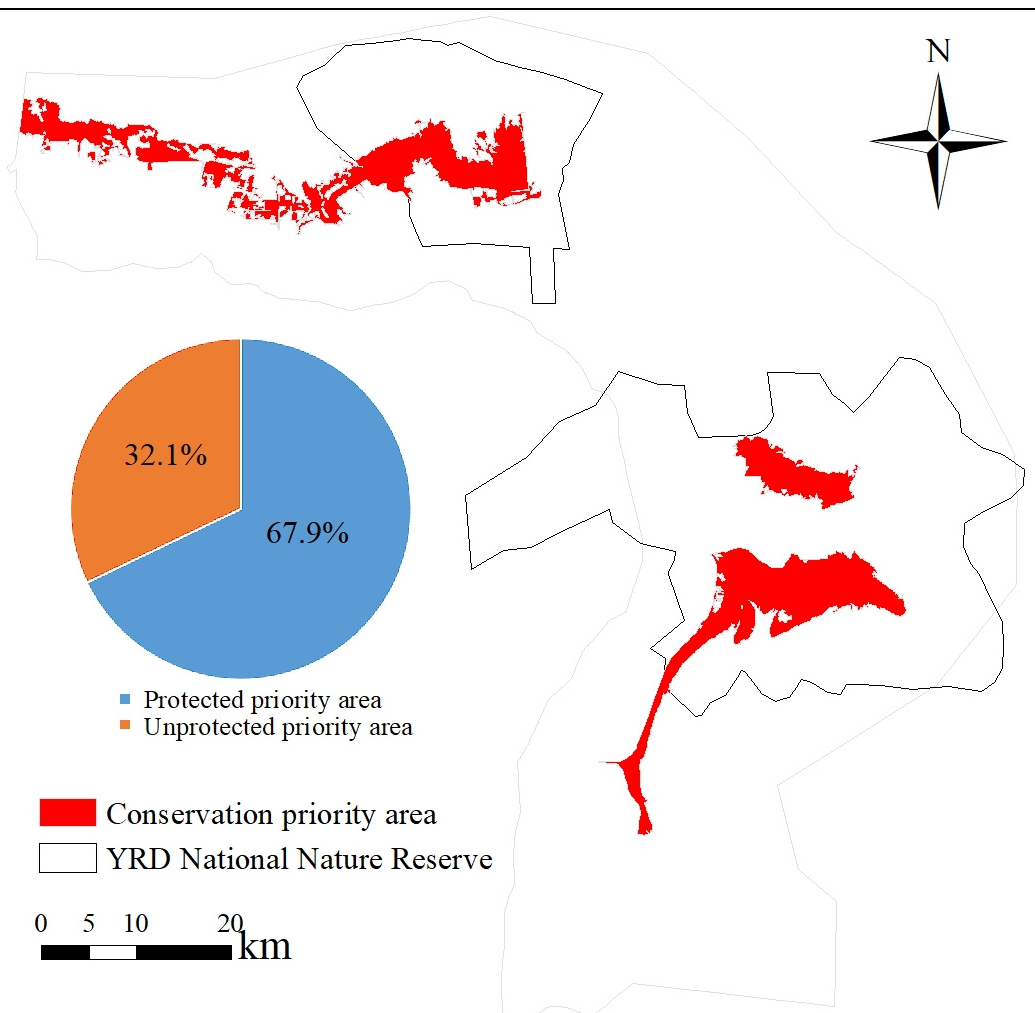
Figure 7. Priority conservation and gap areas in the Yellow River Delta and their percentages.